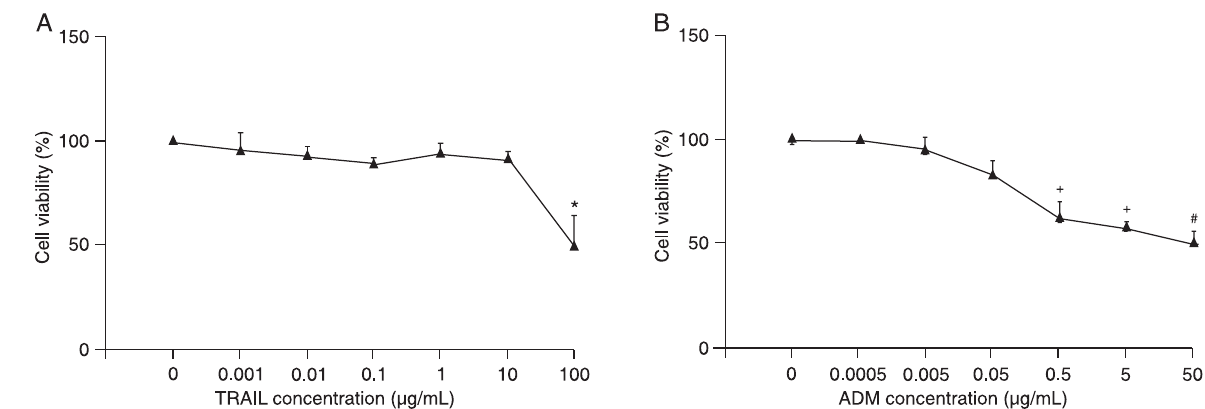
Figure 2. Effect of the combination of TRAIL and ADM on cell viability of MCF-7 cells and analysis of its synergistic effect. MCF-7 cells were incubated with TRAIL (0.01, 0.1, 1, and 10 µg/mL) and ADM (0.005, 0.05, and 0.5 µg/mL) for 24 h. Cell vi- ability was evaluated by the MTT assay. TRAIL = tumor necrosis factor-related apoptosis-inducing ligand; ADM = adriamycin; MTT = 3-(4,5-dimethylthiazol-2-yl)-2,5-diphenyltetrazolium bromide. Data are reported as means ± SD of representative experiments. The synergistic effect was analyzed by the Webb coefficient as described in Material and Methods. Synergism in drug interaction was indicated by observed cell viability of ≤70% of the predicted cell viability. * P < 0.05 compared to the TRAIL alone group (Stu- dent t -test); + Synergistic